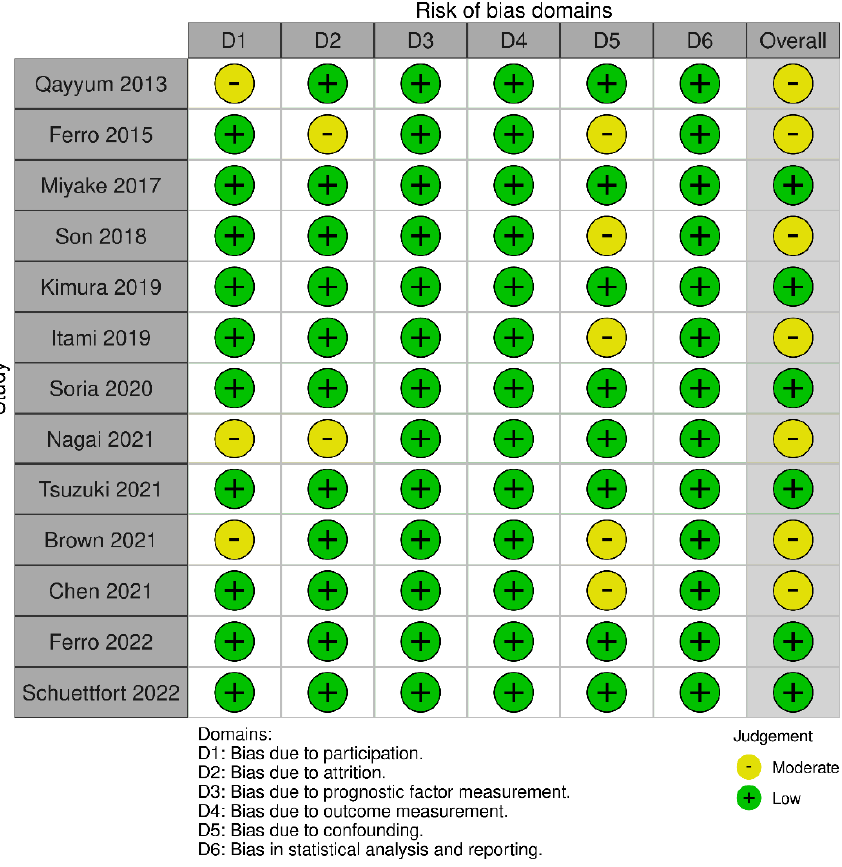
Figure 2. Risk of bias using the Quality in Prognosis Studies tool [20,34]. Low risk of bias; Moderate risk of bias [17,22–33].